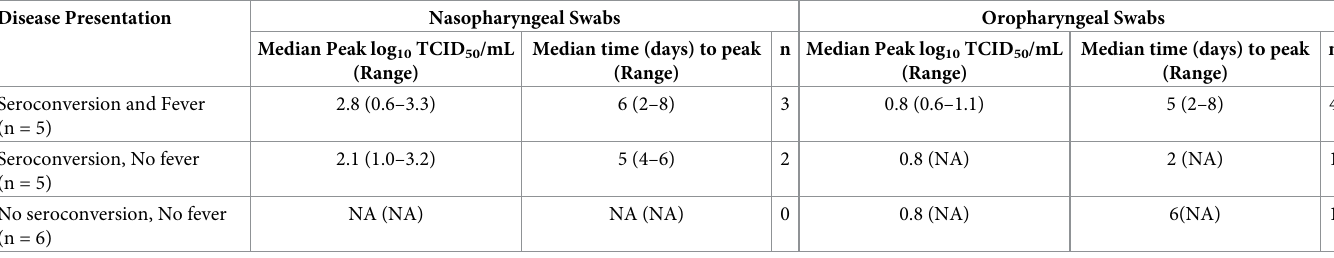
Table 2. Summary of infectious viral shedding in oropharyngeal and nasopharyngeal swabs. Disease Presentation